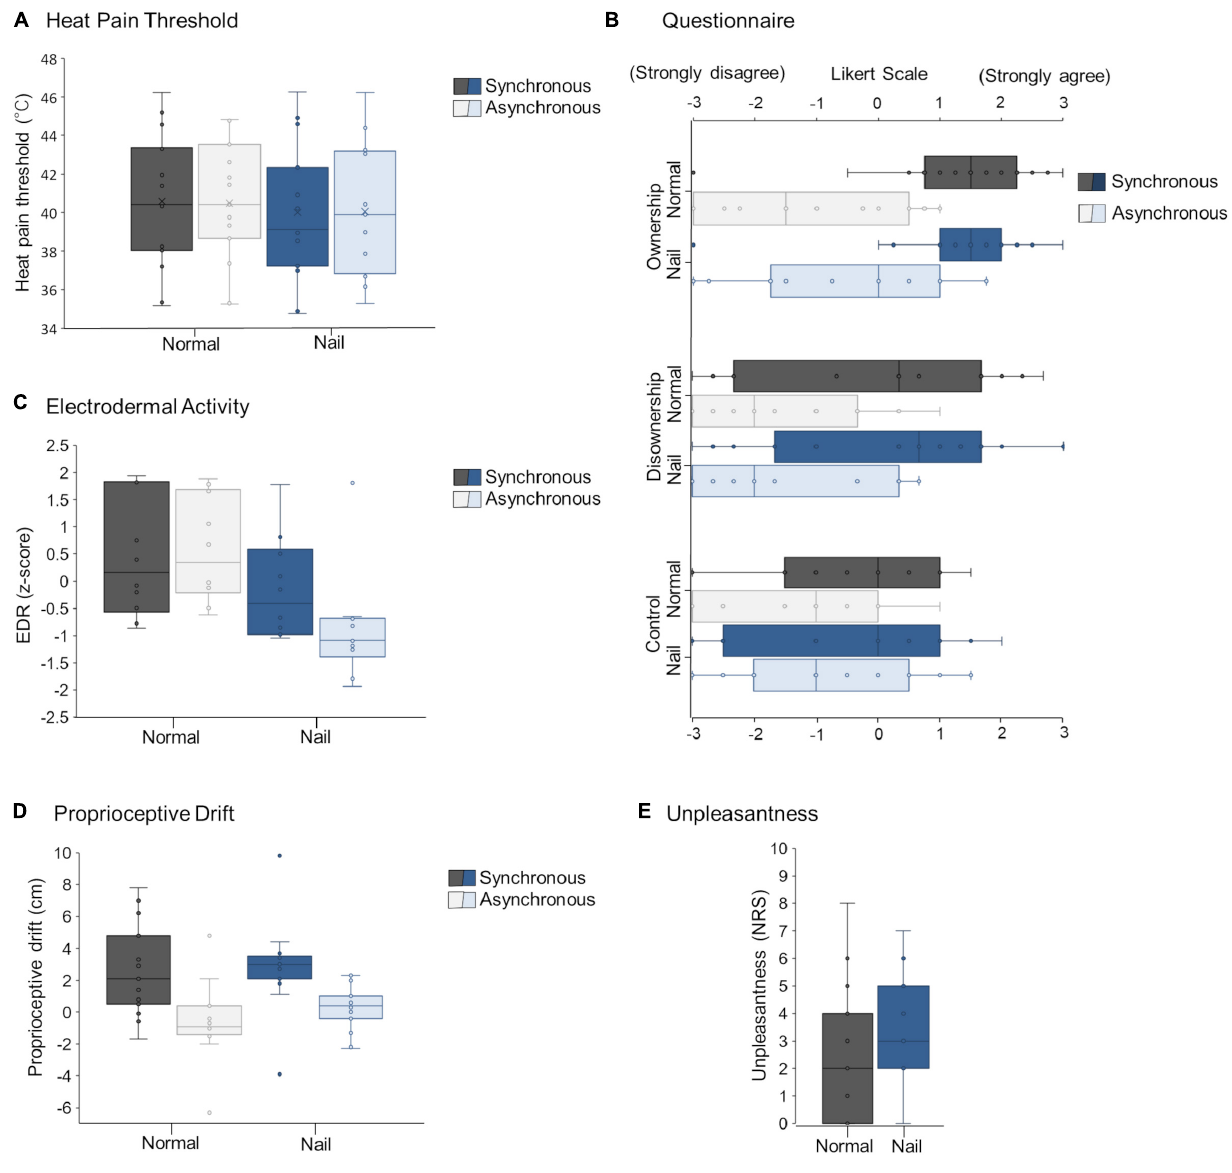
FIGURE 3 | HPT (A) , questionnaire (B) , EDA (C) , proprioceptive drift (D) , and unpleasantness (E) in Experiment